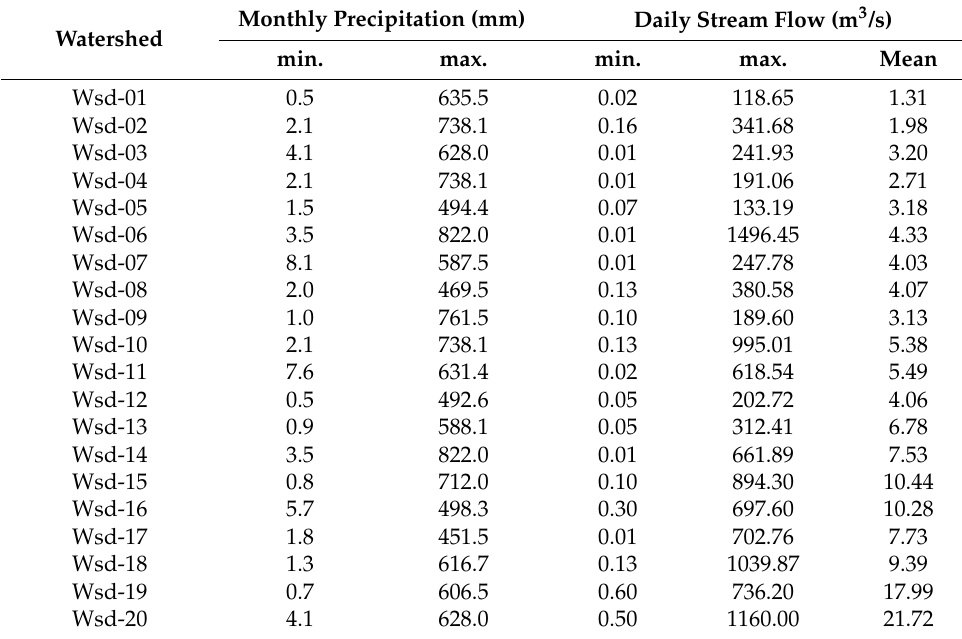
Table 2. Statistics of monthly precipitation and daily stream